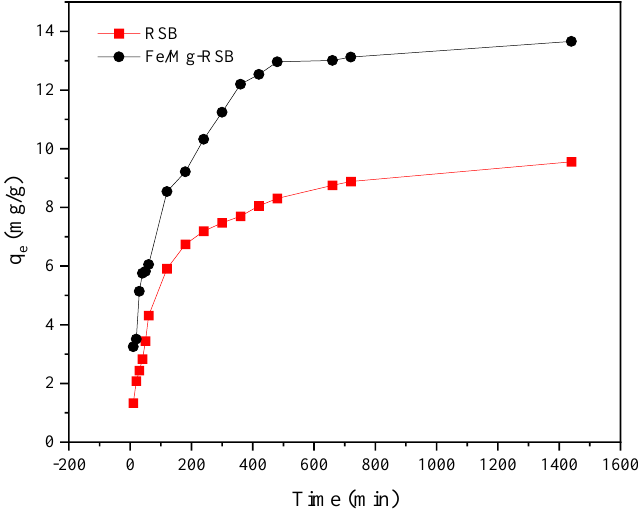
Figure 4. Effect of contact time on the adsorption amount of CQP onto RSB and Fe/Mg-RSB with CQP initial concentration of 10 mg/L.